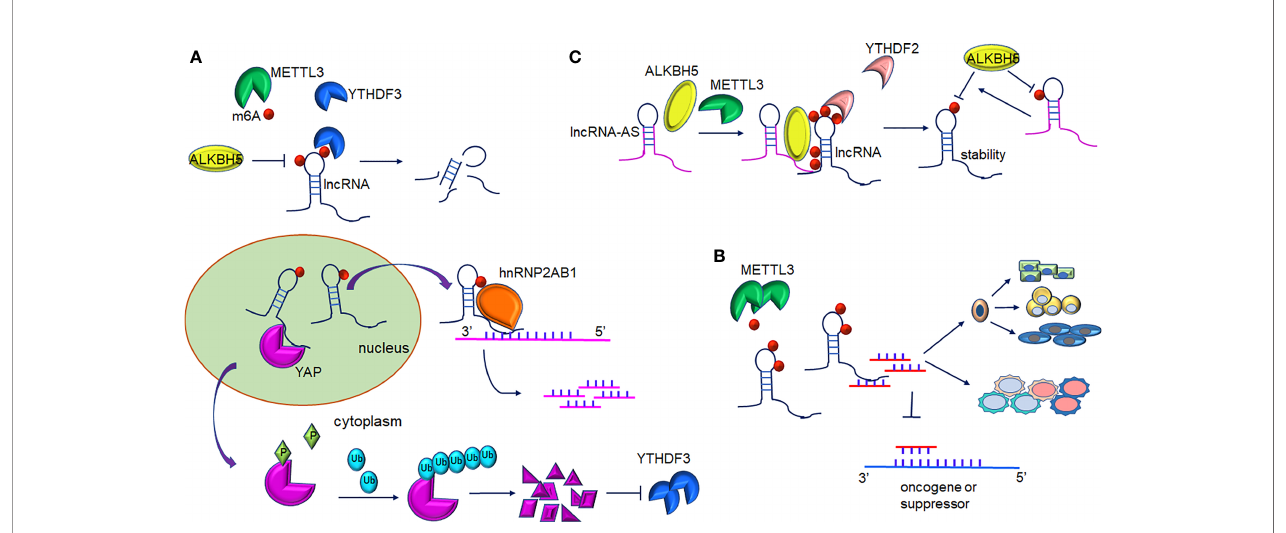
FIGURE 2 | Interplay between lncRNAs and m6A modi fi cation. (A) m6A-mediated lncRNAs target mRNA/protein. m6A-lncRNA GAS5 targets endogenous YAP, which induces YAP degradation and downregulation of its target YTHDF3. In turn, YTHDF3 promotes degradation of m6A-modi fi ed GAS5. m6A-lncRNA RP11 binds to the mRNA of FBXO45 and SIAH1 promoting their degradation. (B) m6A-mediated methylation of lncRNA-miRNAs activity in gene expression. METTL3-mediated m6A-lncRNAs methylation serves as a sponge to restrain miRNA activity and thus abolishes miRNAs-modulated mRNA inhibition. Furthermore, interaction of lncRNA and miRNA contribute to proper differentiation of mouse embryonic stem cells and the in fl ammatory response of cells. (C) The role of LncRNA-AS in m6A-mediated regulation. LncRNA can directly interact with ALKBH5 or METTL3. GAS5-AS binds to m6A-GAS in a YTHDF2-dependent manner and reduces its stability. Furthermore, demethylation of GAS5 is mediated by ALKBH5 and GAS-AS facilitate this process. ARHGAP5-AS1 can recruit METTL3 to stimulate the m6A modi fi cation of ARHGAP5 and increase its stabilization in the